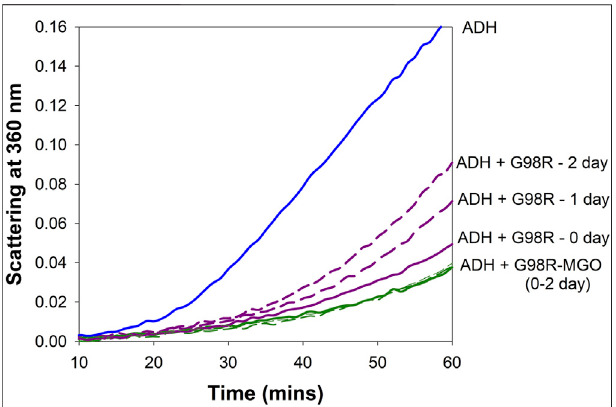
FIGURE 6 | MGO modi fi cation improves the chaperone activity of α AG98R protein. The incubations were set up at different periods to carry out the chaperone assay of all the samples simultaneously. In the absence of MGO, the ability of α AG98R (25 µg), incubated at 37 ° C, to suppress EDTA-induced aggregation ofADH (250 µg) progressively decreases with the incubation duration. At the same time, α AG98R modi fi ed by 50 µM MGO showed improved chaperone activity and was maintained during